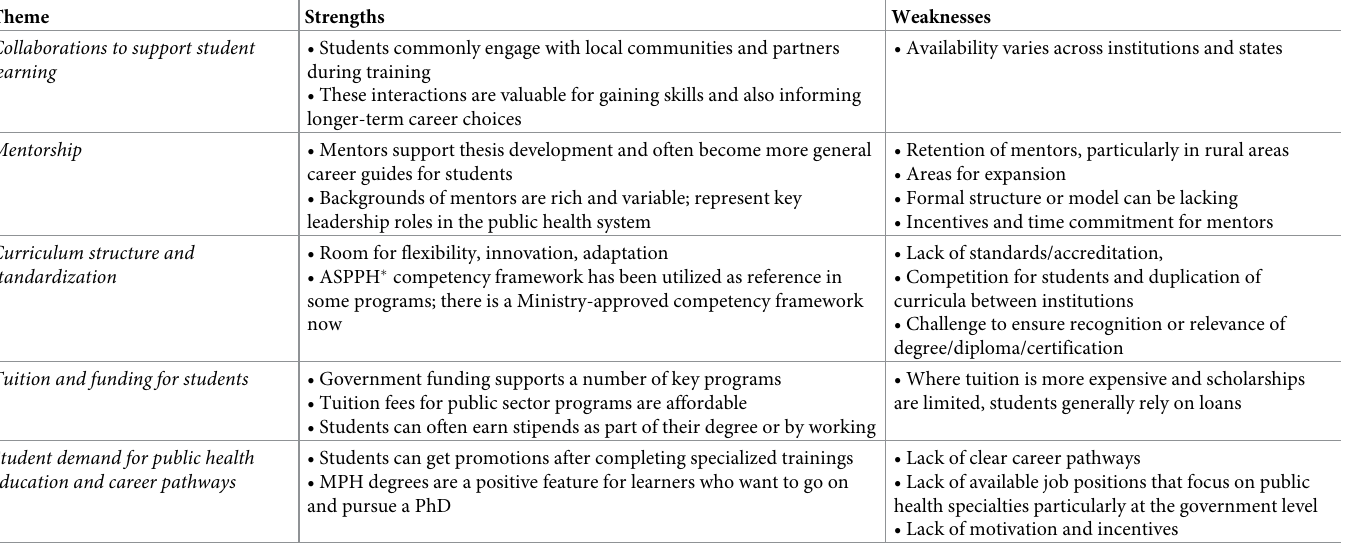
Table 2. Key themes related to student body and curricula for public health education in